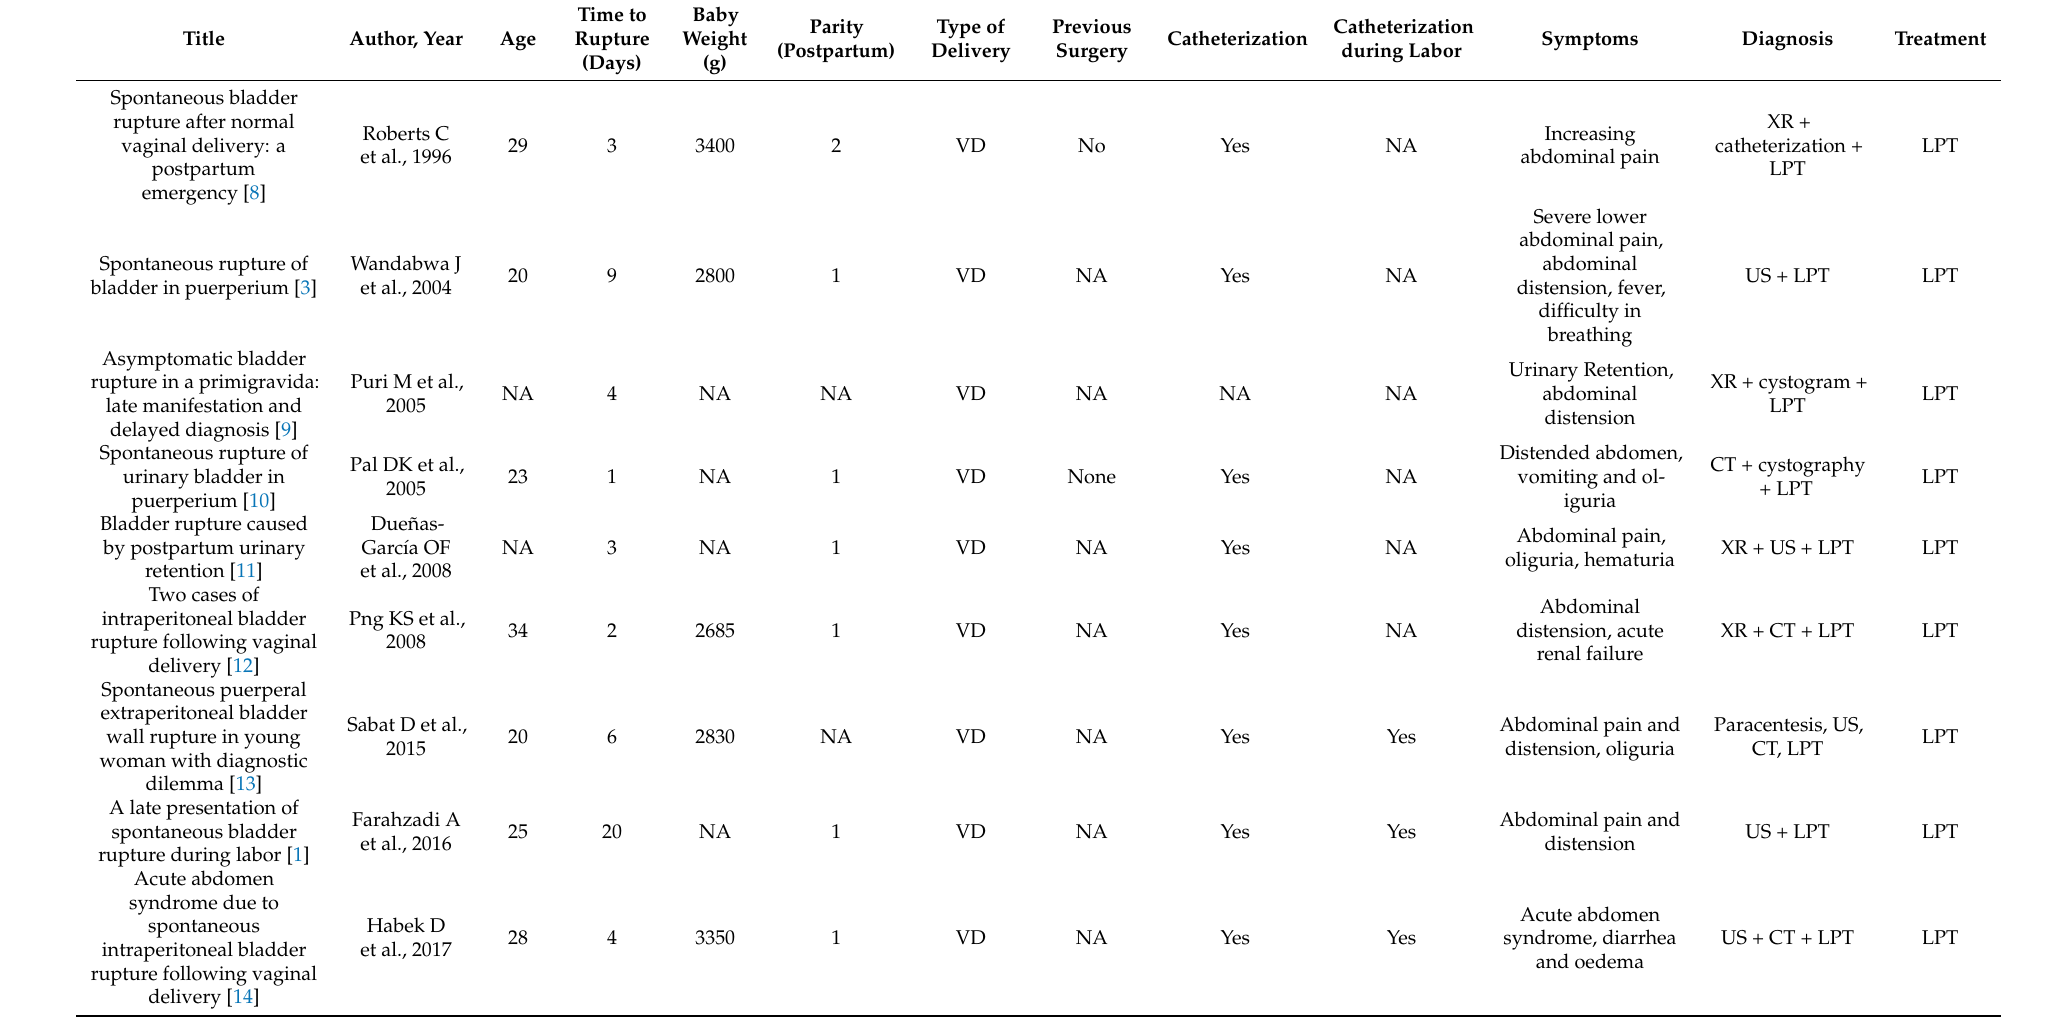
Table 2. Cases in the